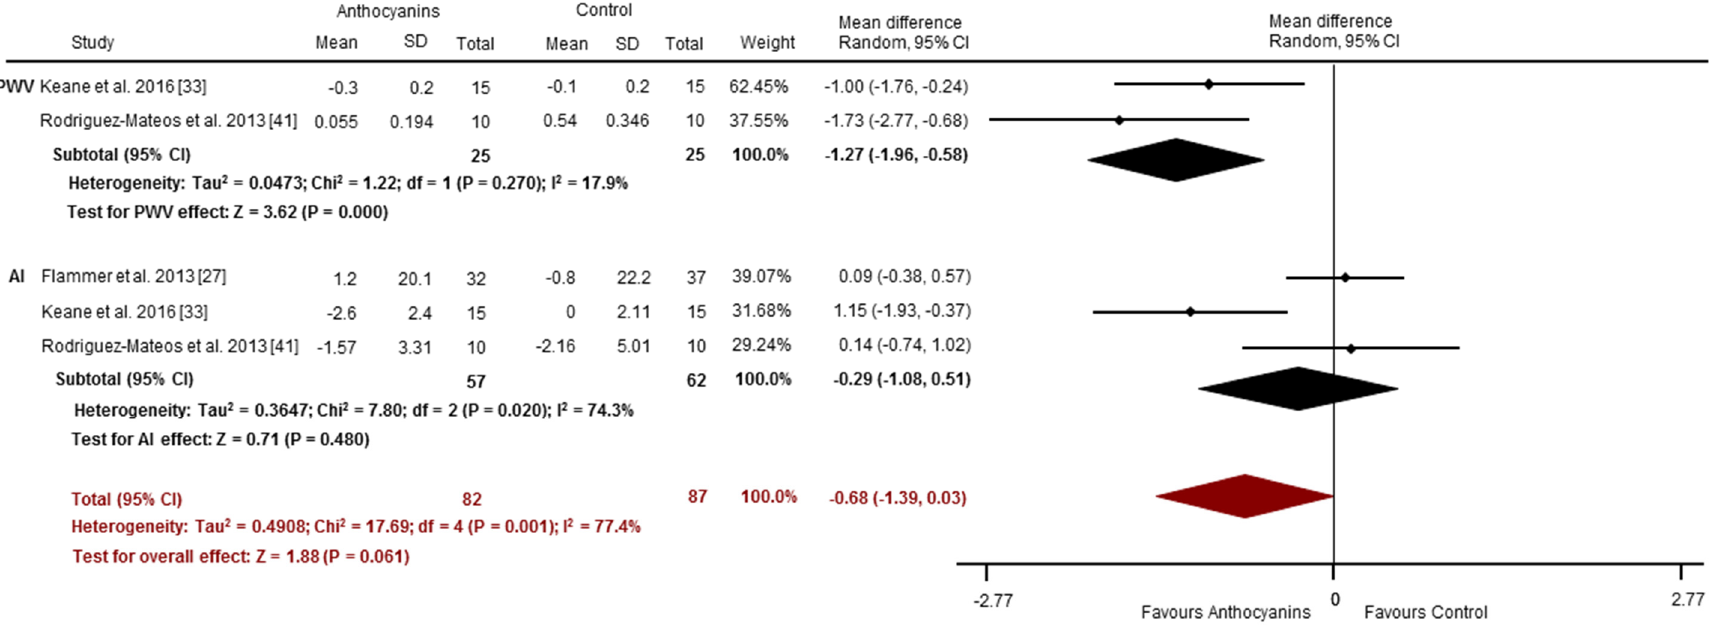
Figure 4. Acute effects of anthocyanins relative to control for vascular stiffness (assessed via PWV and AI). The forest plot has one line representing each study in the meta ‐ analysis, plotted according to the mean difference (indicated by the black diamond in each line). The horizontal line joins the lower and upper limits of the 95% CI of these effects. The black diamond at the bottom of each graph represents the average effect size for PWV and AI studies. The red diamond represents the average effect size for all studies assessing vascular reactivity.